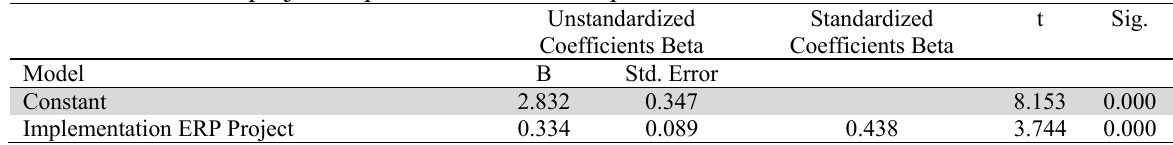
Direct effect of ERP project implementation on firm performance